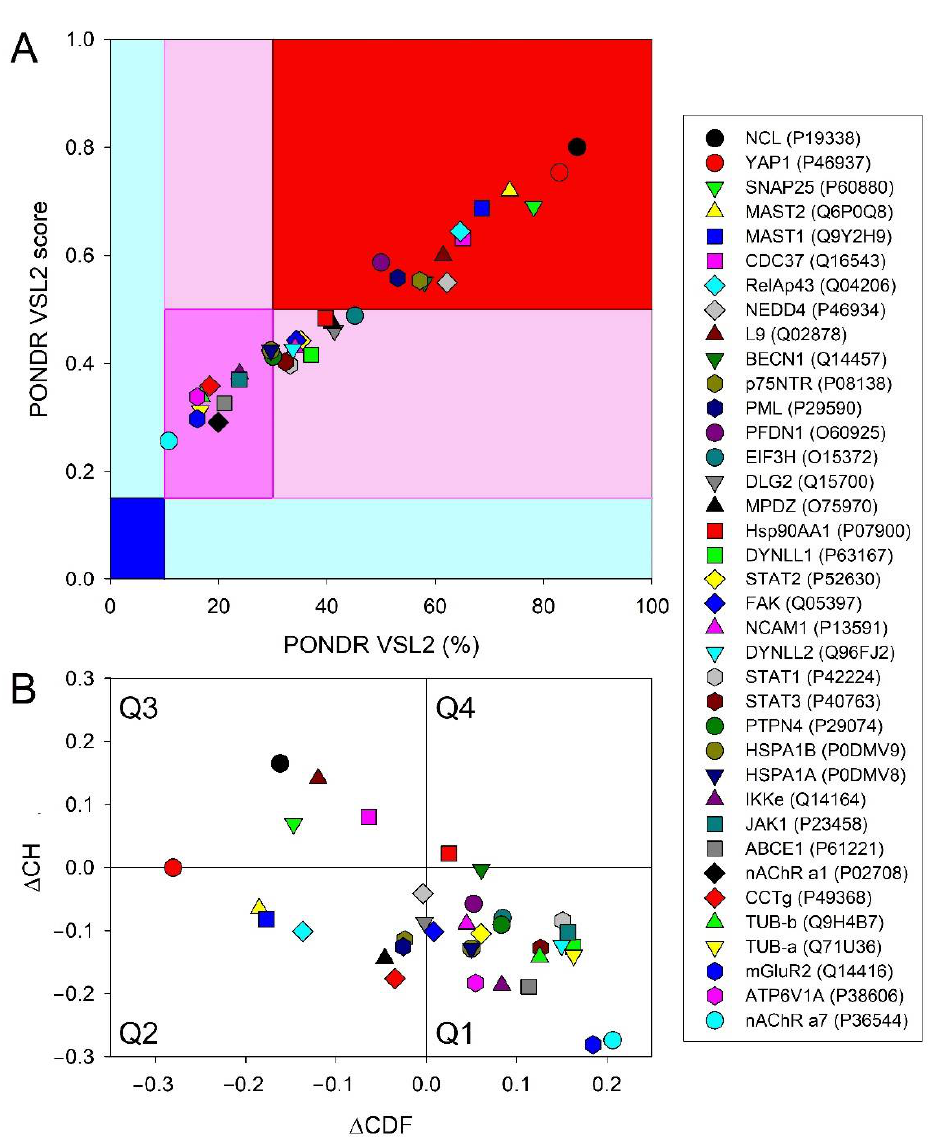
Figure 7. Evaluation of global disorder in 37 human proteins interacting with the RABV proteins. ( A ) PONDR ® VSL2 output for 37 human proteins. The PONDR ® VSL2 score is the average disorder score (ADS) for a protein. PONDR ® VSL2 (%) is the percent of predicted disordered residues (PPDR). i.e., residues with disorder scores above 0.5. Color blocks indicate regions in which proteins are mostly ordered (blue and light blue), moderately disordered (pink and light pink), or mostly disordered (red). If the two parameters agree, the corresponding part of the background is dark (blue or pink), whereas light blue and light pink reflect areas in which only one of these criteria applies. ( B ) Charge-hydropathy and cumulative distribution function (CH-CDF) plot. The Y-coordinate is calculated as the distance of the corresponding protein from the boundary in the CH plot. The X-coordinate is calculated as the average distance of the corresponding protein’s CDF curve from the CDF boundary. The quadrant in which the protein is located determines its classification. Q1, protein predicted to be ordered by the CH-plot and CDF. Q2, protein predicted to be ordered by the CH-plot and disordered by the CDF-plot. Q3, protein predicted to be disordered by the CH-plot and CDF. Q4, protein predicted to be disordered by the CH-plot and ordered by CDF.